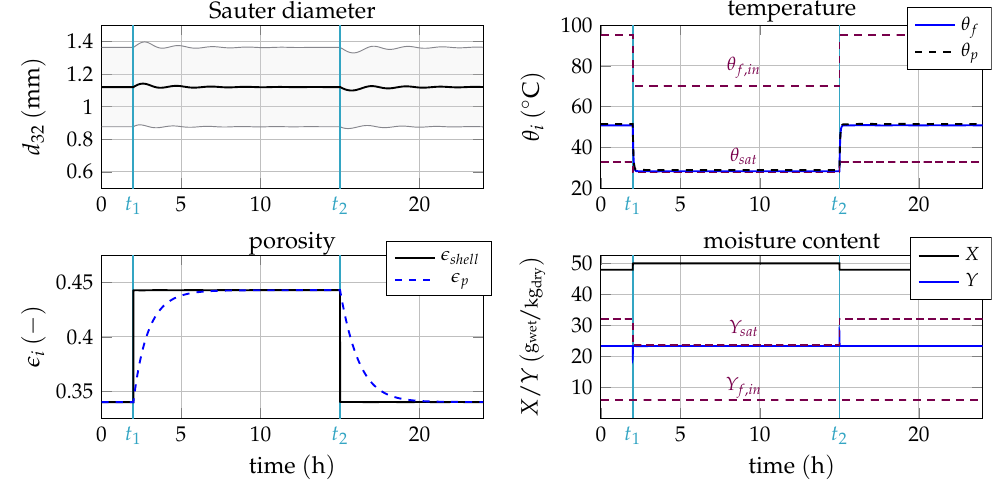
Figure 11. Simulation results of the third scenario: the reduction of the temperature of the fluidization medium θ f , in from 95 ◦ C to 70 ◦ C at t 1 shifts the saturation point. This induces variations of thermal conditions and thus to a change of shell e shell and particle porosity e p . After resetting θ f , in to the default value at t 2 , the dynamic states and particle properties settle at the (initial) steady state again.